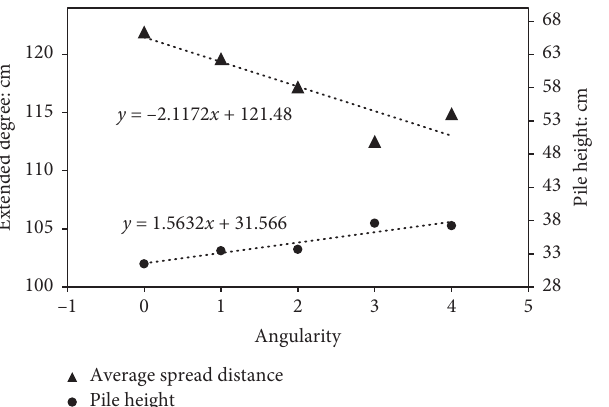
Figure 12: Pile height and extended degree change with the angularity.